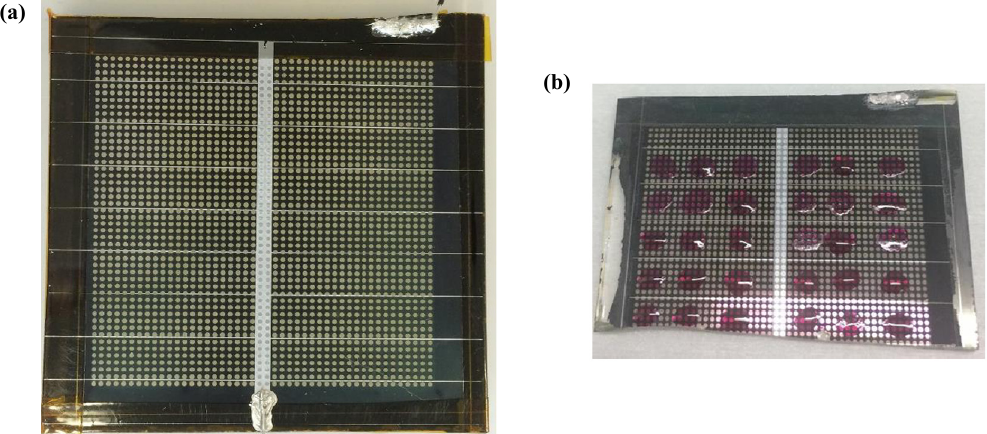
Fig. 5. (a) View of a completed device over the 5 (cid:3) 5cm 2 patterned substrate, with Ni/Al contacting grid deposited on top of the ZnO layer, (b) and on a part of this sample the preparation of isolated smalls cells with varnish (around 0.1cm 2 ).